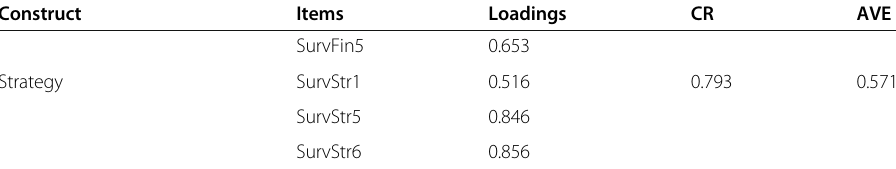
Table 1 Internal consistency, convergent validity, composite reliability, and AVE (Continued)